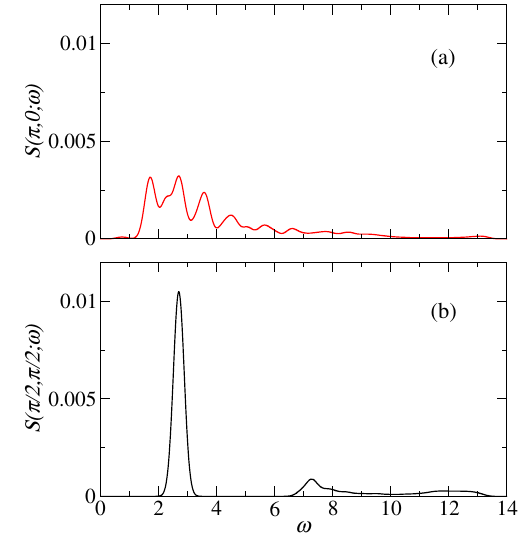
FIG. 21. Spectral functions as in Fig. 20 but with the parameters of the effective model chosen to give behaviors similar to the J - Q model with Q ≈ J : c m ¼ 3 . 1 , c s ¼ 6 . 2 , Δ ¼ 0 . 39 , g ¼ 1 . 86 , and the spinon-spinon potential V ð r Þ ¼ − 6 . 2 e − r= 2